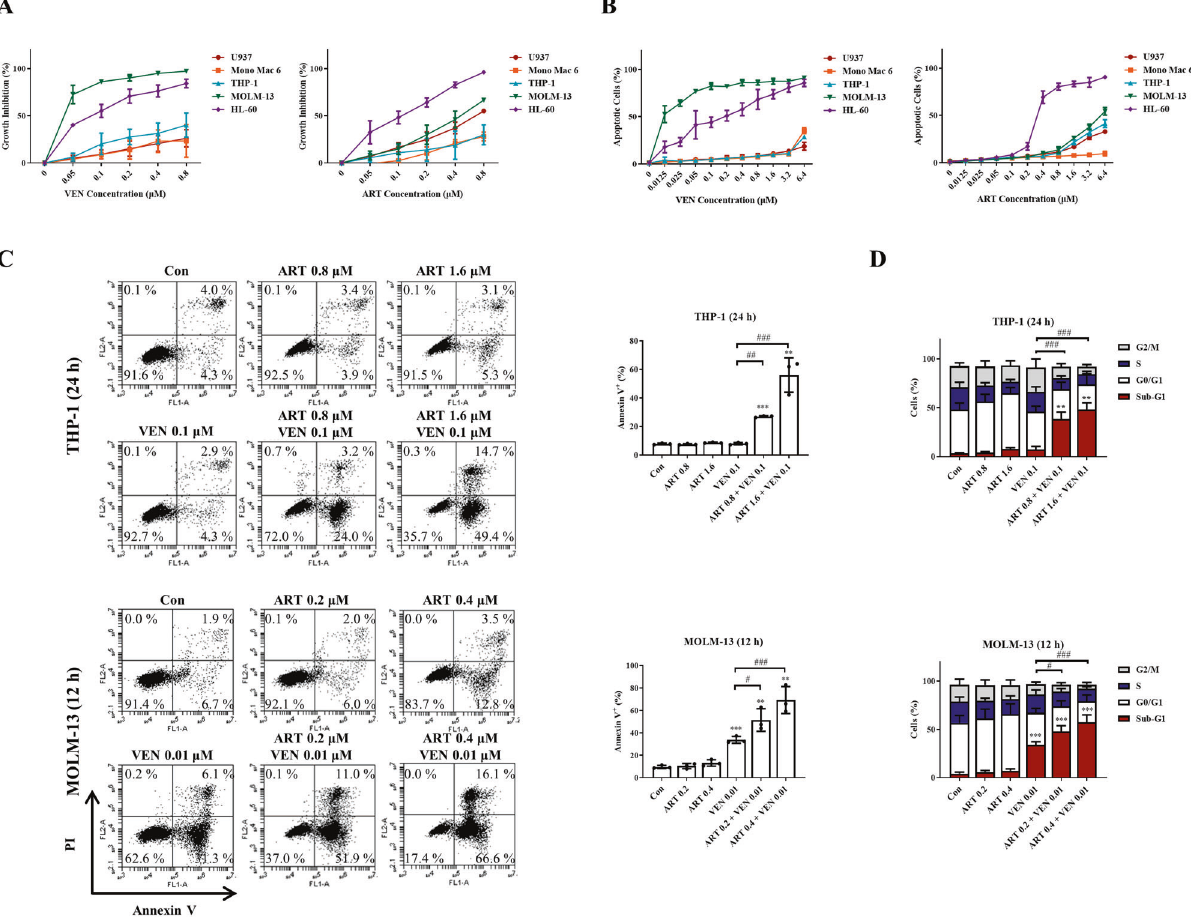
Fig. 2 Venetoclax (VEN) in combination with artesunate (ART) induce synergistic antileukemia effects in AML cells. A Growth inhibition of venetoclax or artesunate in fi ve AML cell lines. Cells were treated with venetoclax or artesunate for 72 h. Cell growth inhibition was measured by counting cell number and compared to the untreated group. B Apoptotic cells were determined based on morphological observation using a fl uorescence microscope after staining with AO and EB. Cells were treated with venetoclax or artesunate at the indicated concentrations and times. C THP-1 and MOLM-13 cells were treated with venetoclax, artesunate and in combination at the indicated concentrations and times. Apoptotic cells determined by FACS after staining with Annexin V/PI. D Cell cycle distribution assessed by FACS after PI staining. Values are mean ± SD of three independent experiments. ** P < 0.01; *** P < 0.001 compared to the control group by t -test. # P < 0.05; ## P < 0.01; ### P < 0.001 by two-way ANOVA